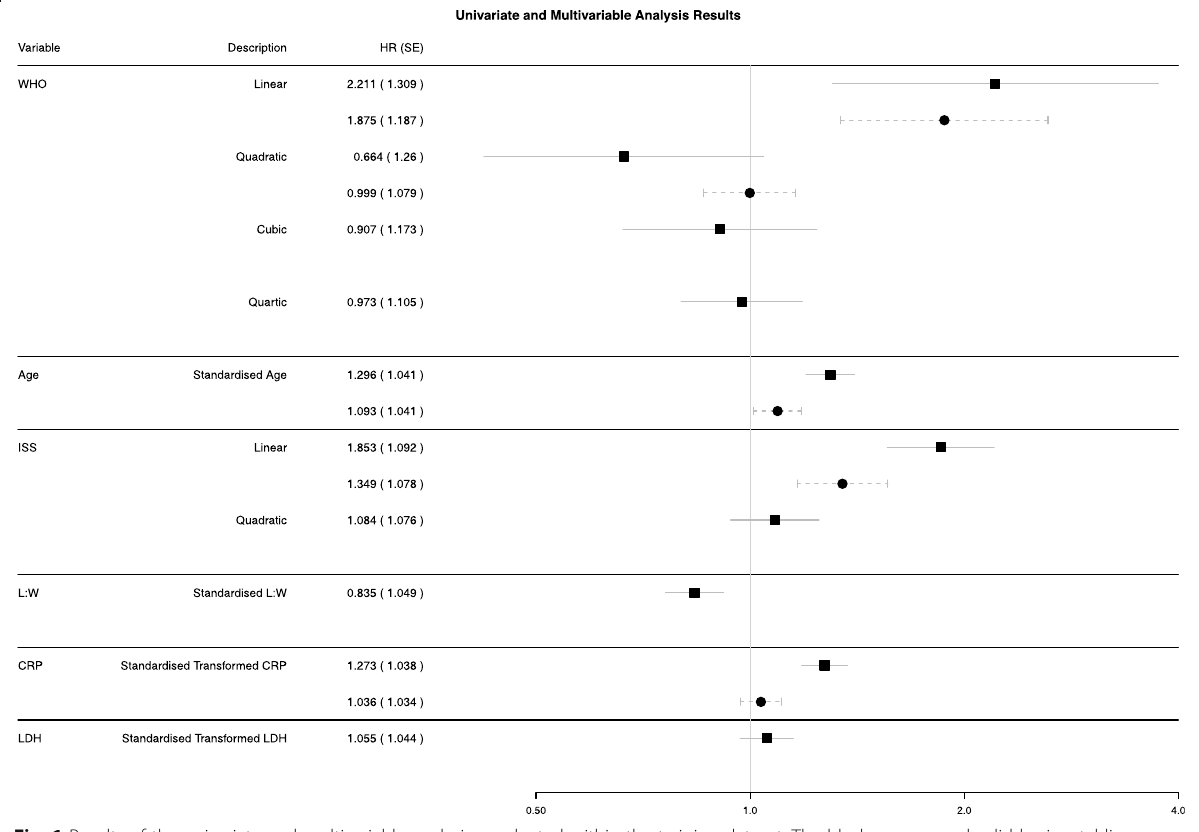
Fig. 1 Results of the univariate and multivariable analysis conducted within the training dataset. The black squares and solid horizontal lines represent the estimate and the associated 95% confidence interval of the proposed prognostic model within a univariate Cox model. The black circles and dashed horizontal lines represent the estimate and the associated 95% confidence interval of the proposed prognostic model within a multivariable penalised Cox model, following the combination of coefficients and bootstrap standard errors across ten imputed dataset using Rubin ’ s rules. If there are no multivariable results for a variable, then this was penalised to zero during the model building process and not included in the final model